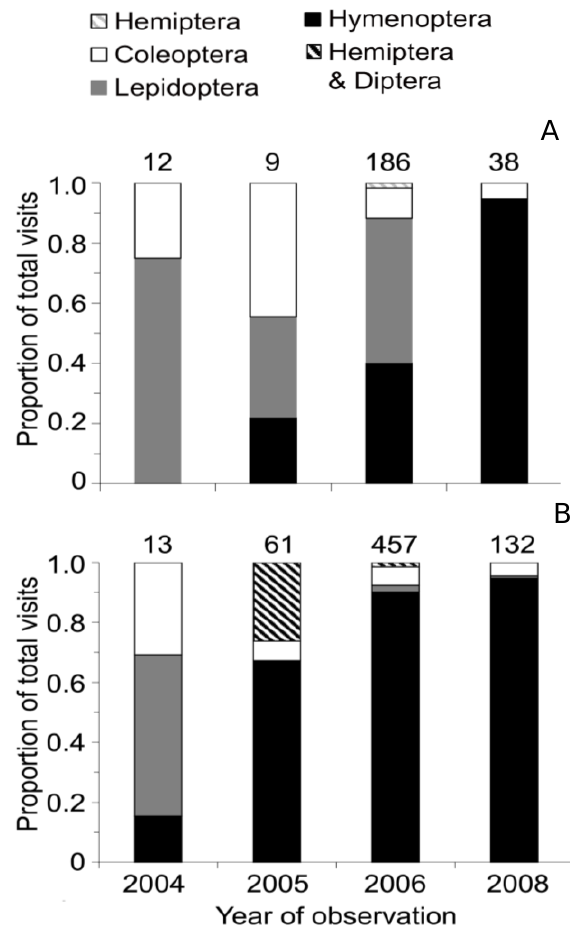
F IGURE 4. Diversity of insect taxa grouped by order that were observed visiting A) H. aponeurus and B) H. flavifolius flowers